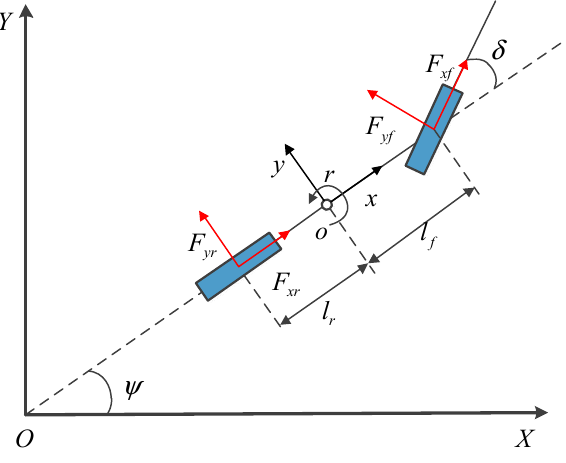
Figure 2. The 2-DOP bicycle-tracking